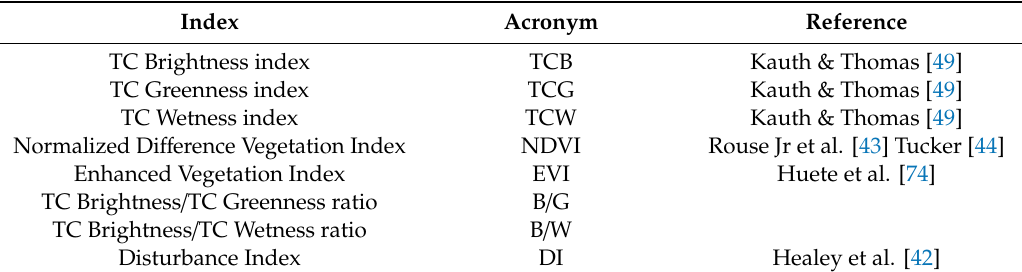
Table 1. List of the eight indices examined in this